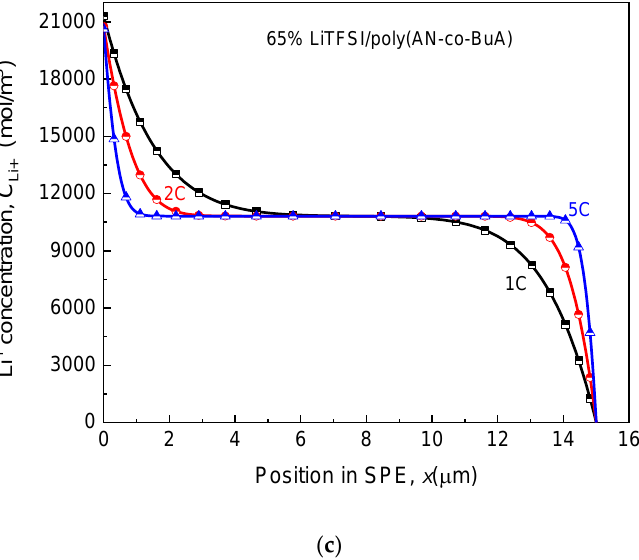
Figure 8. Effect of discharge rate on Li + concentration distribution in SPE under different aging processes. ( a ) Aging time t a = 160 days; ( b ) Aging time ta = 200 days; ( c ) Aging time t a = 240 days.